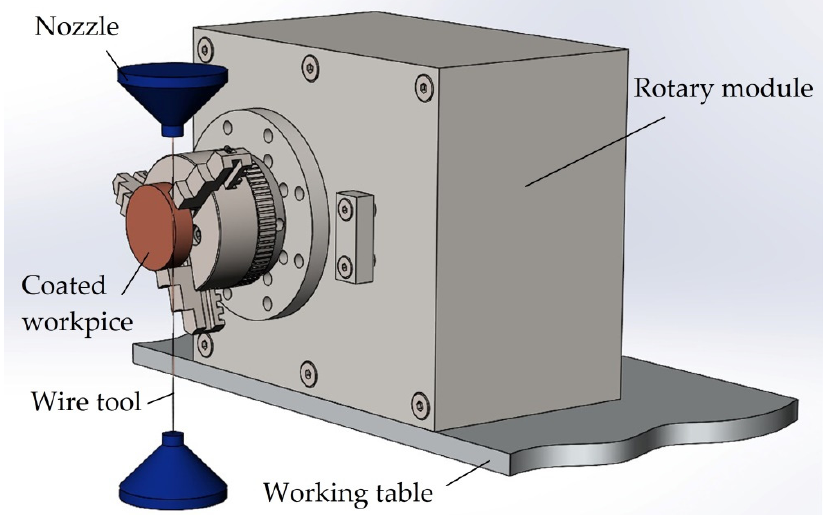
Figure 1. Scheme of coated workpiece microtexturing by wire electrical discharge machining.